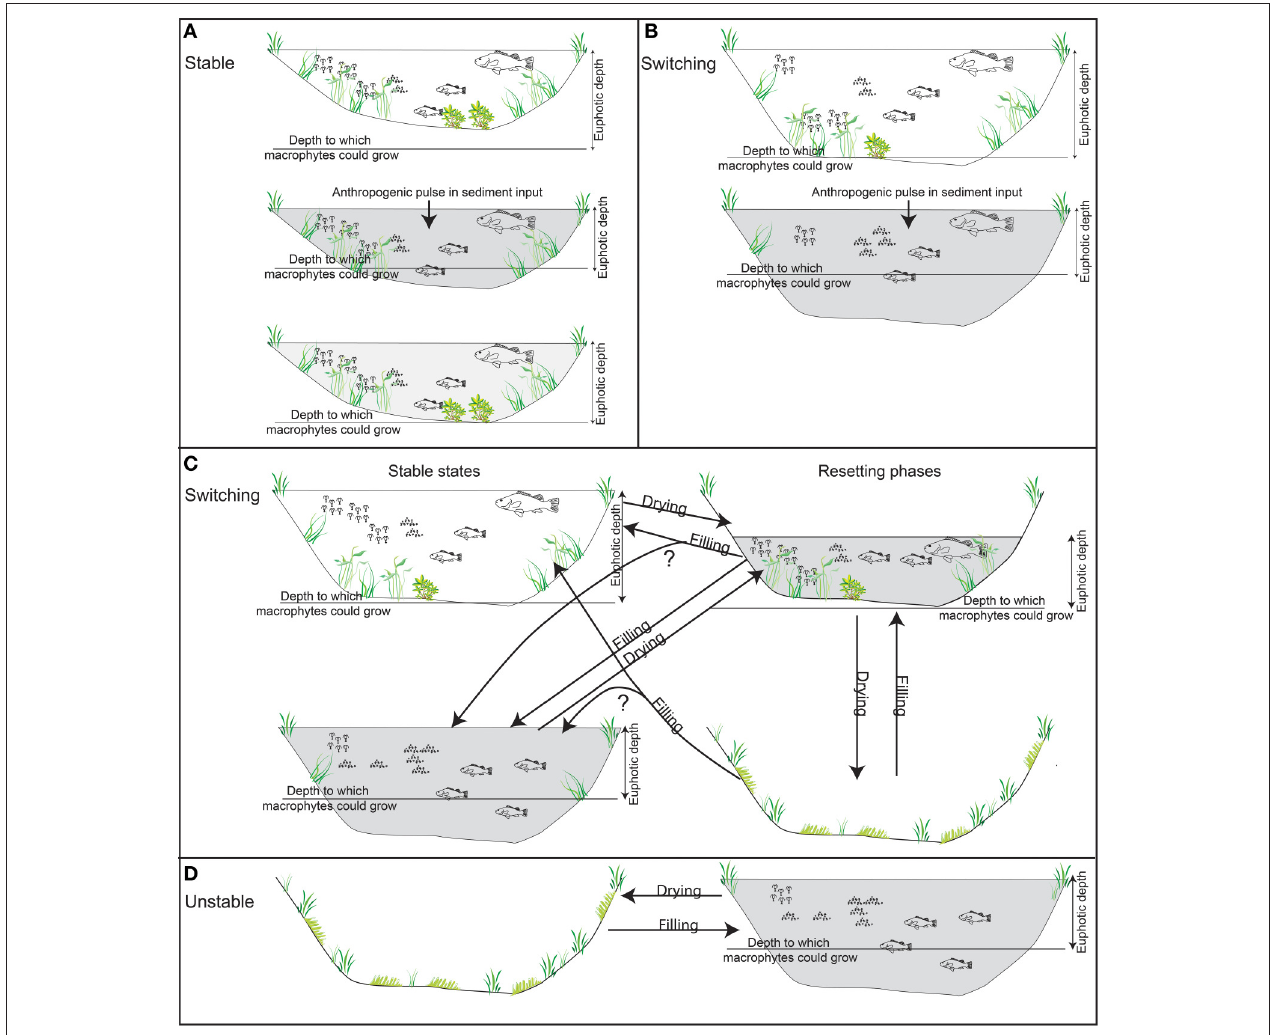
FIGURE 2 | Conceptual models explaining the relationships between billabong geomorphology, hydrology, and the proposed response types. Stable billabongs are resilient to reduced photic depth because pulses in anthropogenic sediment input do not reduce photic depth enough to remove the majority of the bed from the photic zone (A) . Switching billabongs are less resilient to reduced photic depth because pulses in sediment input result in the removal of the majority of the bed from the photic zone (B) . In both cases, feedback processes may act to strengthen the original or new state once sediment influx is reduced. Switching billabongs may also be reset to either state by drying events (C) . Unstable billabongs dry frequently and so fail to develop stable states (D)